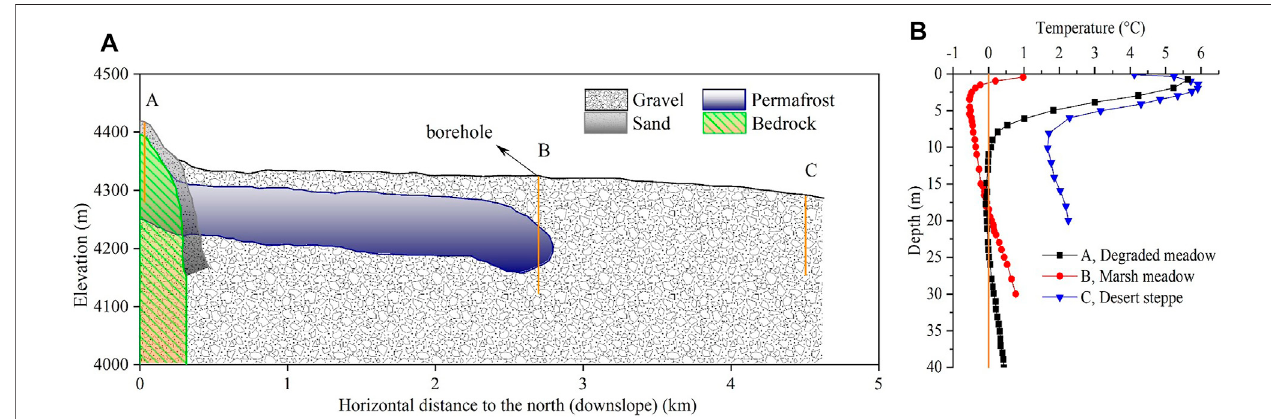
FIGURE 2 | Borehole locations and vegetation types (A) and the corresponding soil temperature (B) . Ground temperatures in Panel 2B were measured on 30 September 2016.